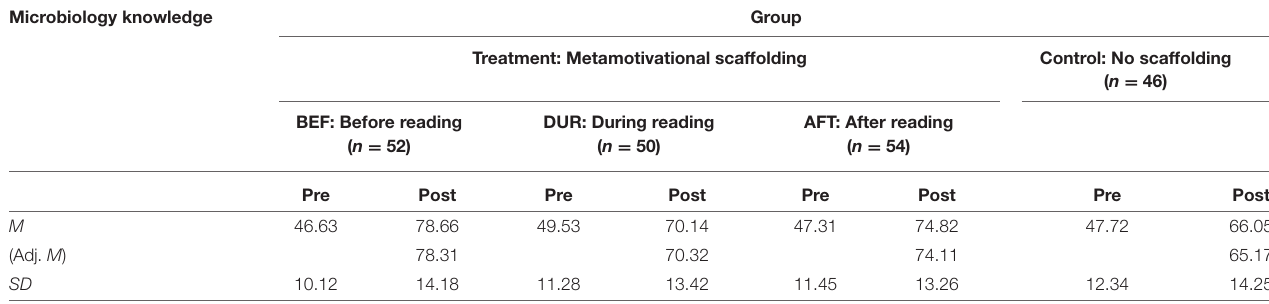
TABLE 5 | Students’ means, standard deviations, and adjusted mean scores on the test of domain-specific science knowledge, by time (pre/post) and treatment. Microbiology knowledge Group Treatment: Metamotivational scaffolding